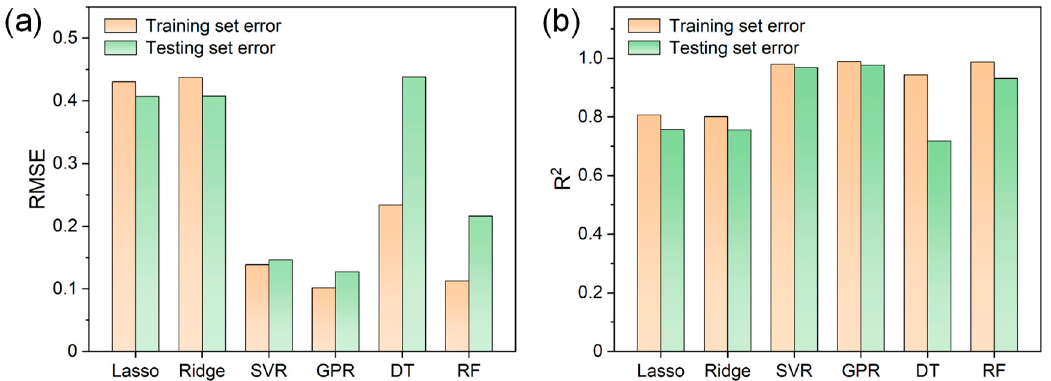
Figure 6. Comparison of accuracy for di ff erent machine learning models: ( a ) RMSE and ( b ) R 2 .